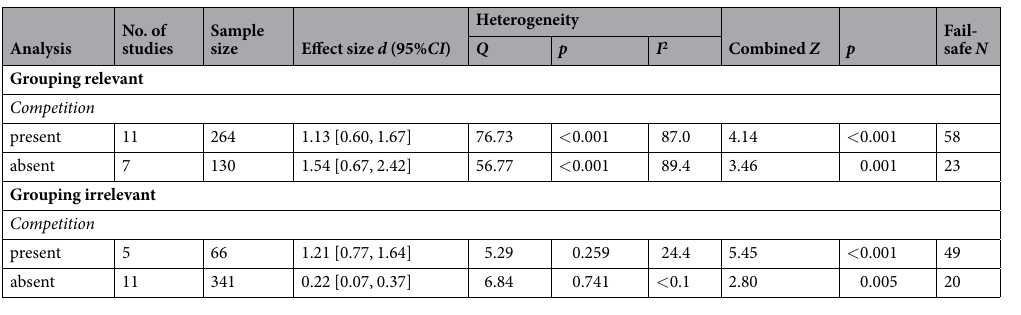
Table 3. Subgroup